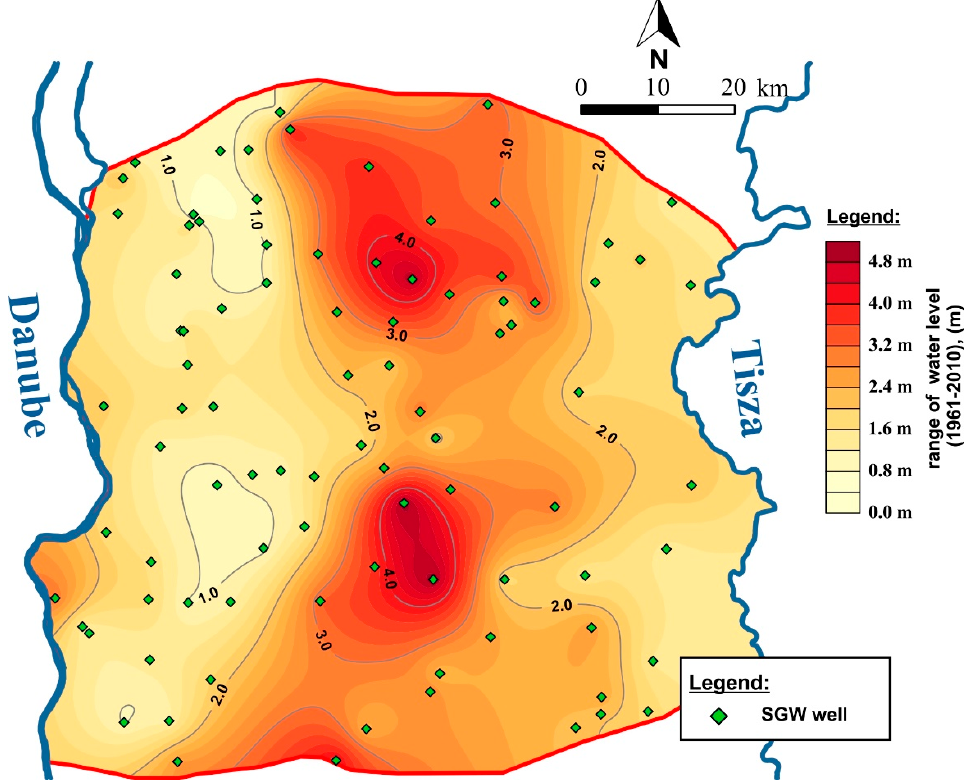
Figure 3. Kriged map of SGW level ranges derived from the 91 SGW wells over the time interval 1961 to 2010. The properties of the semivariogram can be found in Figure S6a.